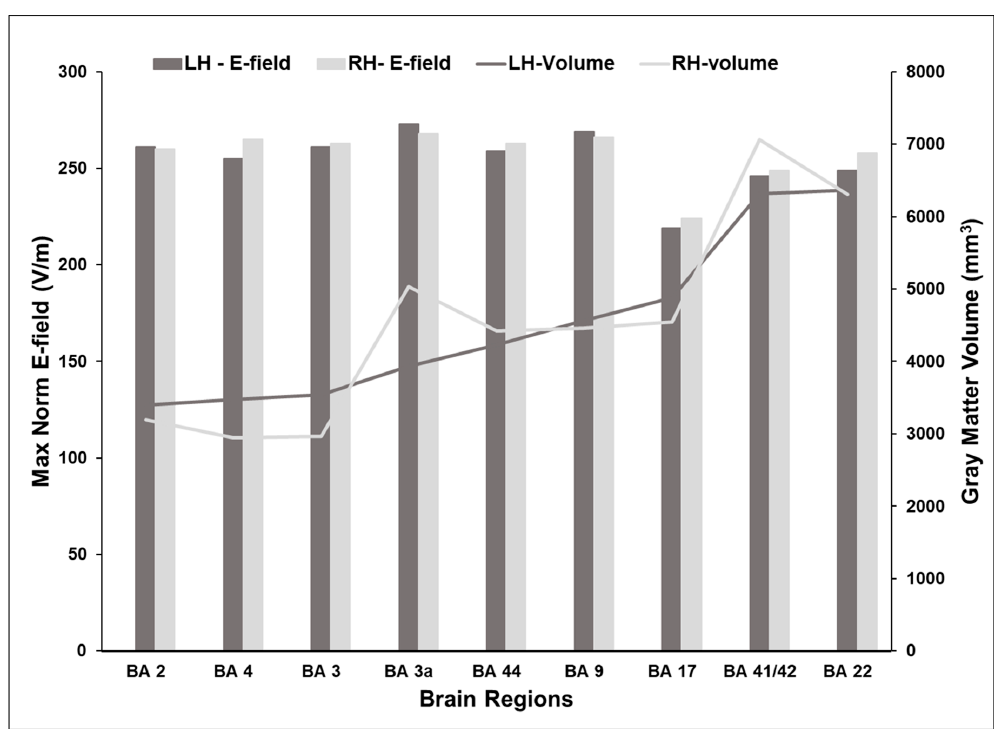
Figure 4. Maximum norm E-field and volume of activated cortex in homologous locations in the left and right hemispheres with the coil oriented towards the nose (EEG position: Nz). The TMS intensity was set at dI/dt = 150 A/µs. The maximum norm or strength of E-fields are shown as bars on the y-axis on the left. Very small differences in norm E-fields were observed between the homologous locations in the left and right hemispheres. The volume of cortex exposed to at least 75% of maximum E-field is plotted as lines on the y-axis on the right. The volume of activated cortex differed at homologous locations in the left and right hemispheres especially in BA 3, BA 3a, and BA 41/42. LH—left hemisphere; RH—right hemisphere.